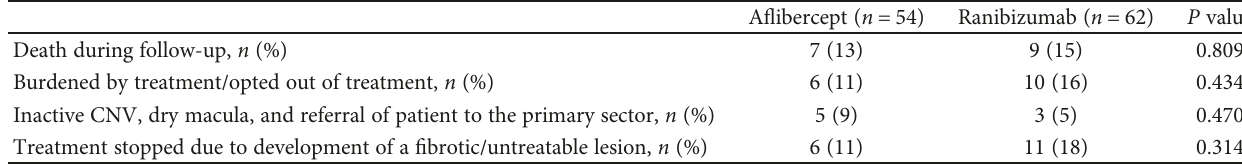
Table 1: Reasons for discontinuation of anti-VEGF treatment using either A fl ibercept or Ranibizumab among patients with neovascular age- related macular degeneration aged ≥ 90